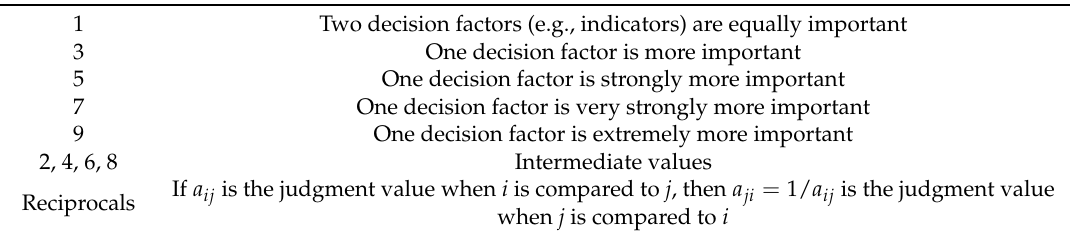
Table 2. Definitions of comparative importance.